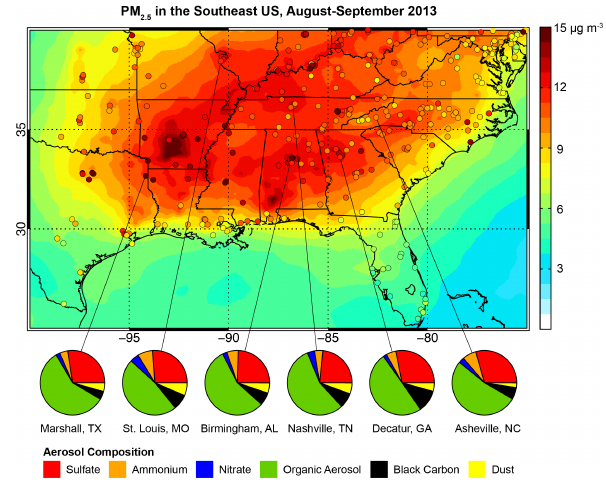
Figure 3. Mean PM 2 . 5 in the southeast US in August– September 2013. EPA observations (circles) are compared to GEOS-Chem model values (background). Model values are calcu- lated at 35% relative humidity as per the Federal Reference Method protocol. Observed mean PM 2 . 5 speciation by mass is shown in the pie charts for representative CSN sites. Organic aerosol (OA) mass concentrations are derived from measurements of organic carbon (OC) by assuming an OA / OC mass ratio of